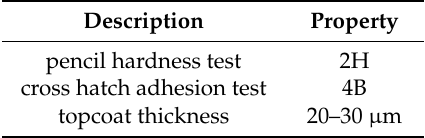
Table 1. Basic coating properties of two-coat system with sol-gel topcoat.